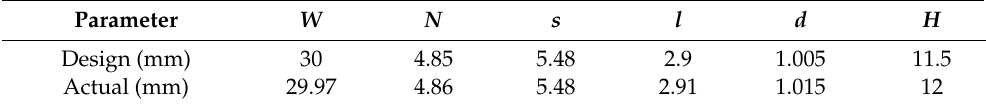
Table 2. Comparison of some dimensions between the design and actual model.